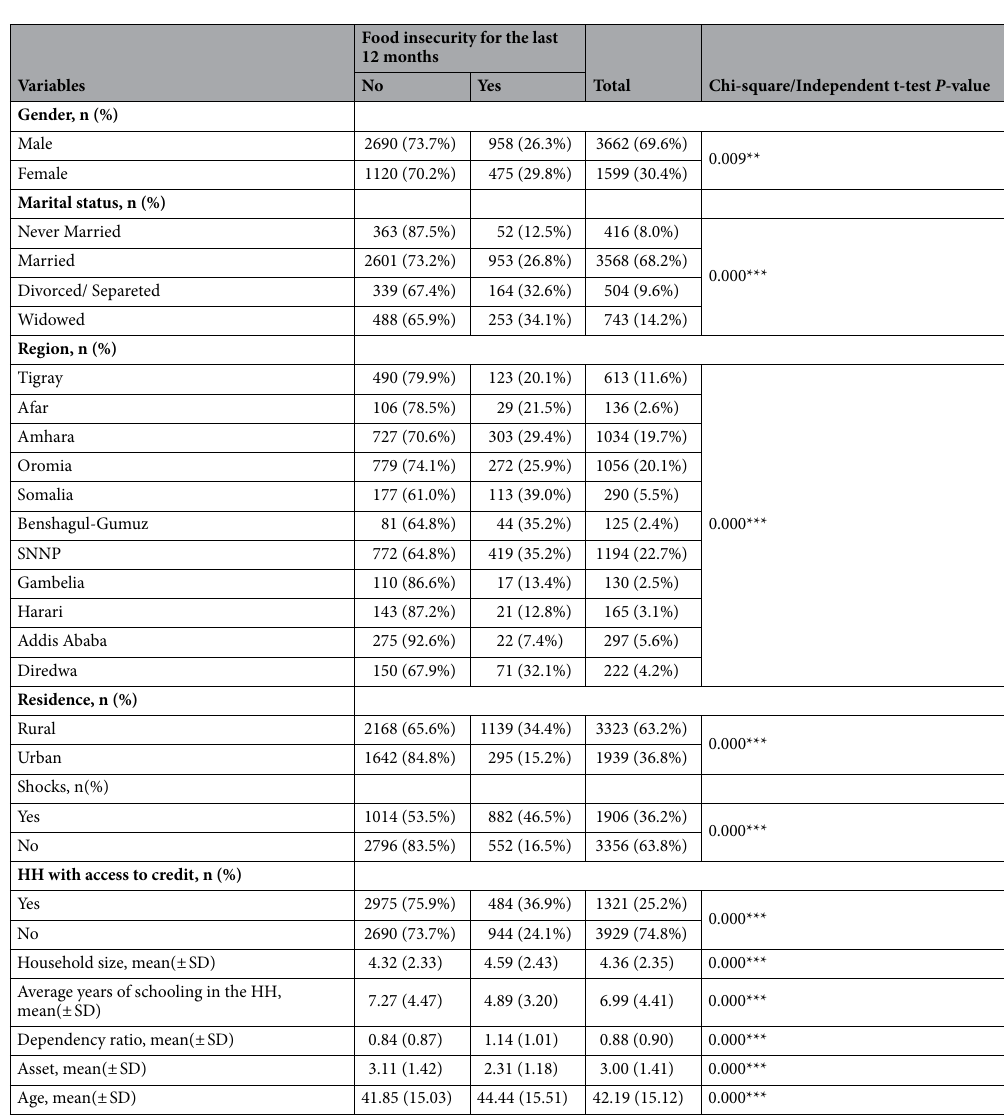
Table 1. Association between household level food insecurity and geographic, demographic and socio- economic variables.